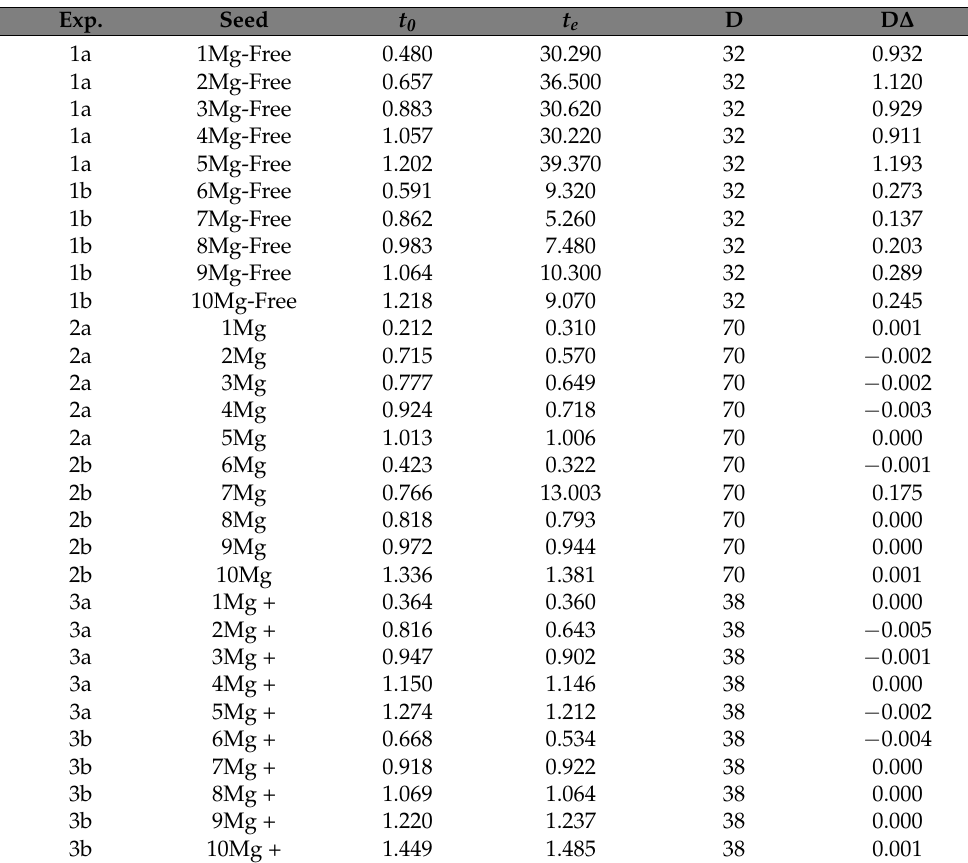
Table A1. Initial and final seed weights, including the duration of the experiment and the standard- ized weight change. Experimental identification corresponds to the aqueous conditions detailed in Table 1. The seed weight values are listed in grams, the experimental identification code is listed as Exp., the individual CaCO 3 bioclast identification is listed under Seed, the initial weight and end weight of the seed material correspond to column t 0 and t e , the number of days in the experimental conditions is in column D (variation in experimental duration was due to unexpected health and safety issues), and the standardized weight change per day (g d − 1 ) is in column D ∆ . Exp.